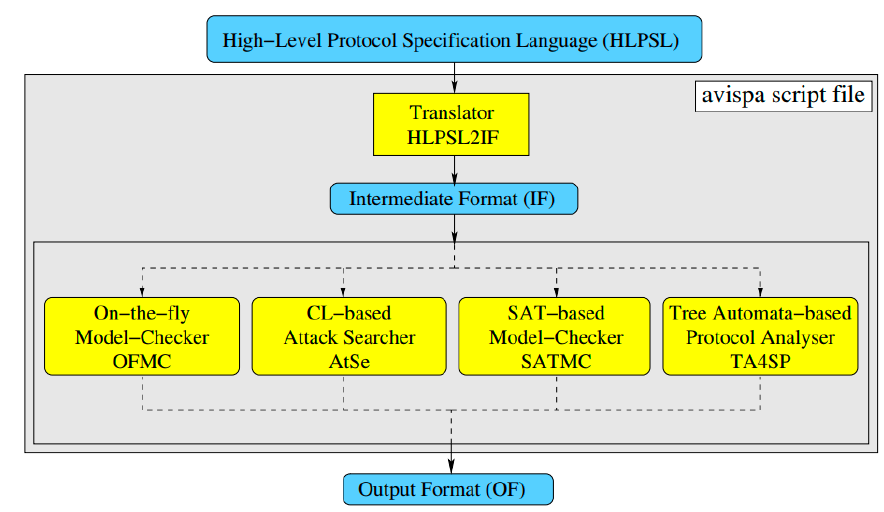
Figure 5. Architecture of the automated validation of internet security protocols and applications (AVISPA) tool v.1.1 [67]. Table 1. Notations used in proposed algorithm.